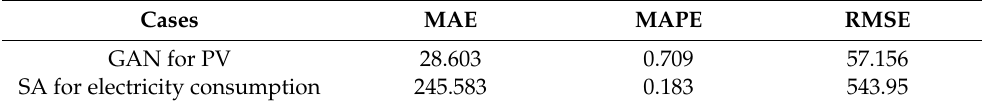
Table 4. Parameters of DDPG method in this paper.